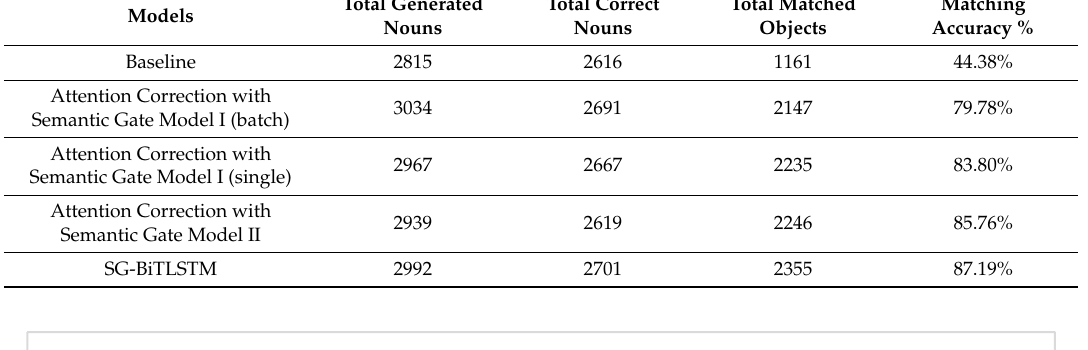
Table 4. Locations accuracy of the models.